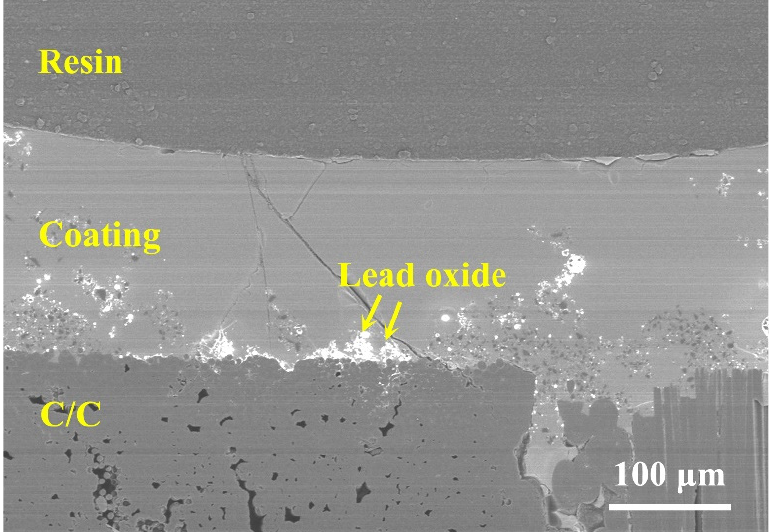
Figure 11. Cross-sectional morphology of PSN/lead–borosilicate glass–B 4 C coated C/C with Pb20 at 900 °C for 10 h in air.